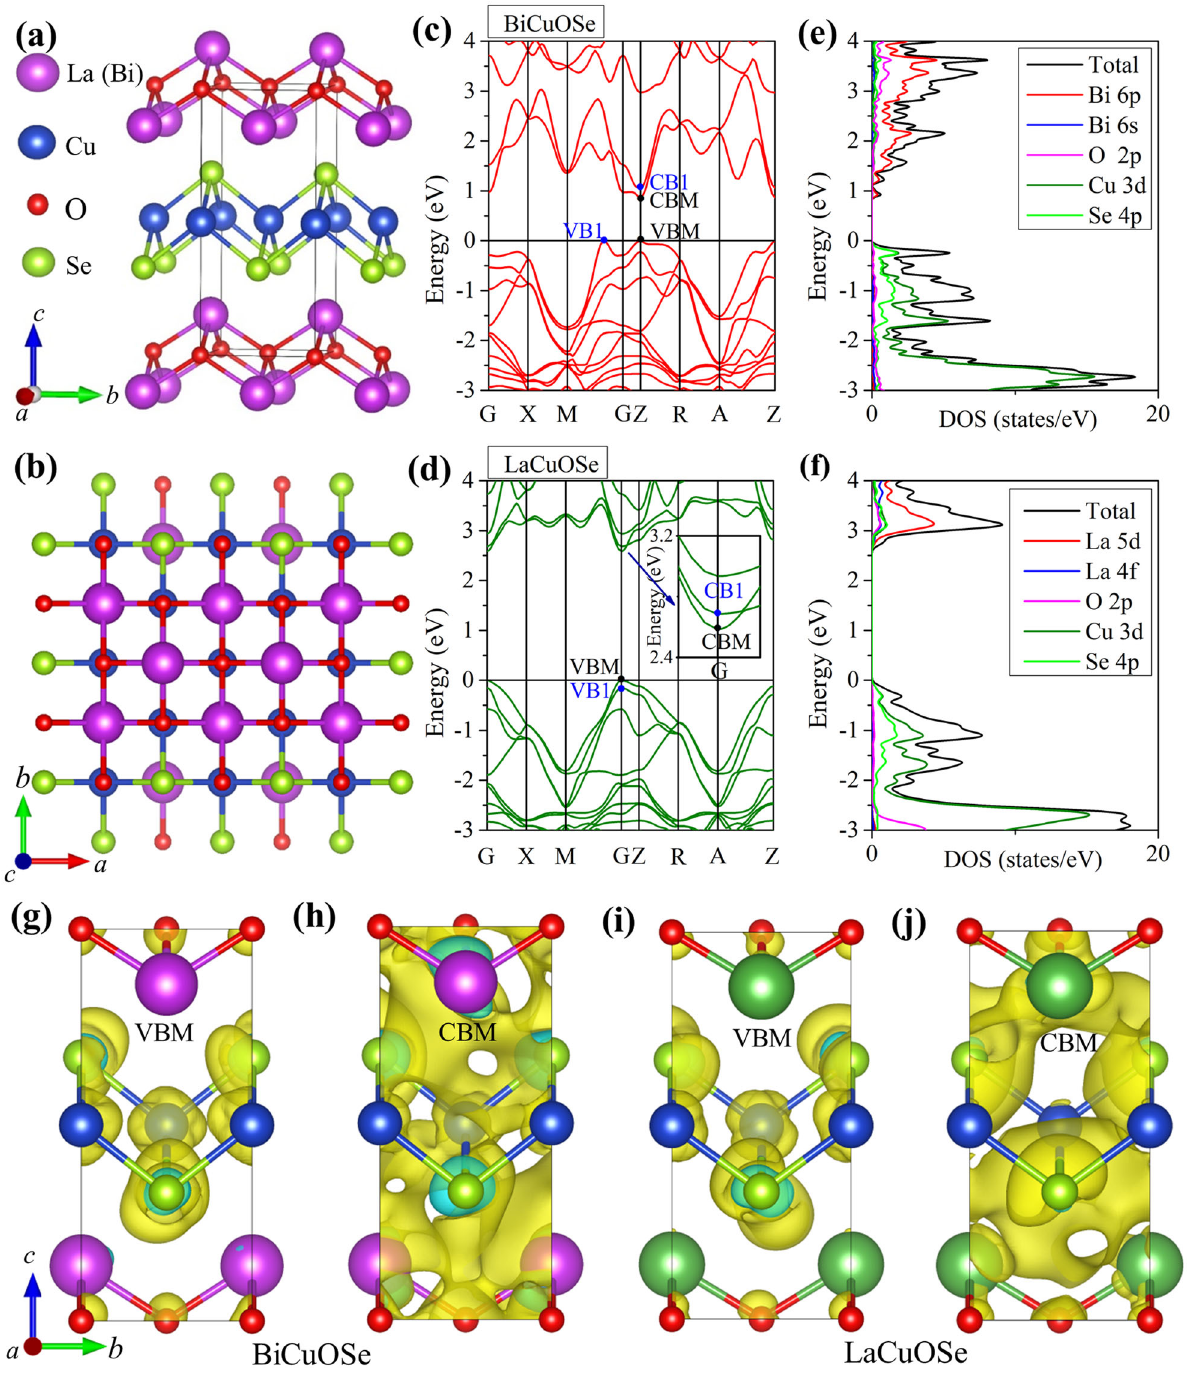
Fig. 2 The crystal and electronic structures. The side view ( a ) and top view ( b ) of crystal structures, band structures ( c , d ) and density of states ( e , f ) for BiCuOSe and LaCuOSe. The calculated band decomposed charge densities near the Fermi level ( g – j ) for BiCuOSe and